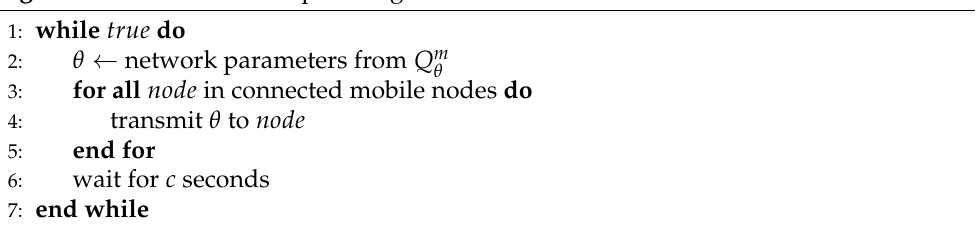
Algorithm 9 Mobile ANN update